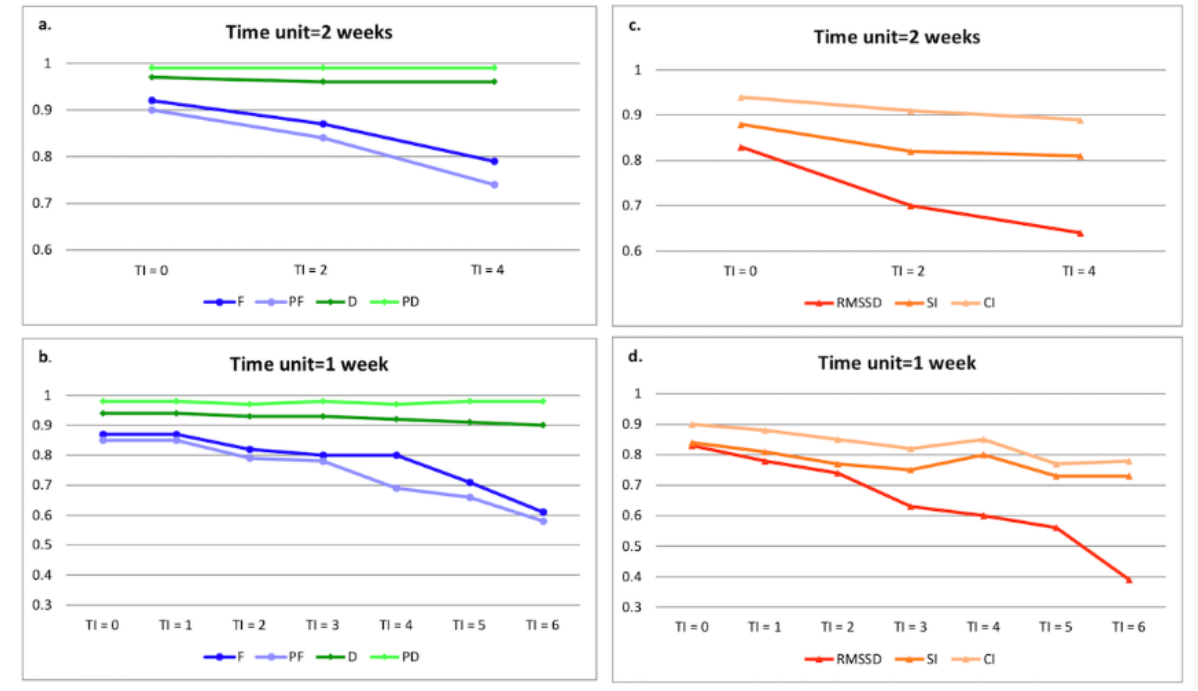
Figure 4. The temporal stability of app-generated parameters: Independent cycle. (a) The correlations of 2 independent 2-week uses with different time intervals for daily use frequency and duration parameters. (b) The correlations of 2 independent 1-week uses with different time intervals for daily use frequency and duration parameters. (c) The correlations of 2 independent 2-week-use periods with different time intervals for RMSSD, the SI, and the CI. (d) The correlations of 2 independent 1-week-use periods with different time intervals for RMSSD, the SI, and the CI. CI: Control Index; D: Total use duration; F: Total use frequency; PD: Proactive use duration; PF: Proactive use frequency; RMSSD: root mean square of the successive differences (between the adjacent duration of use and nonuse episodes); SI: Similarity Index; TI: Time interval